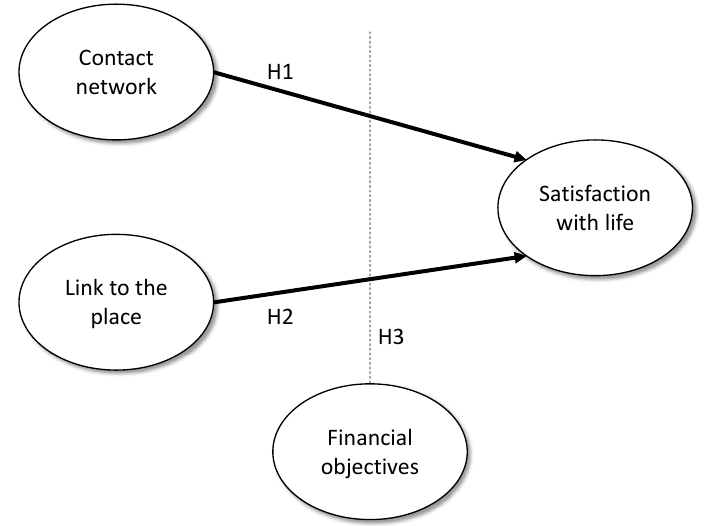
Figure 1. Conceptual model.